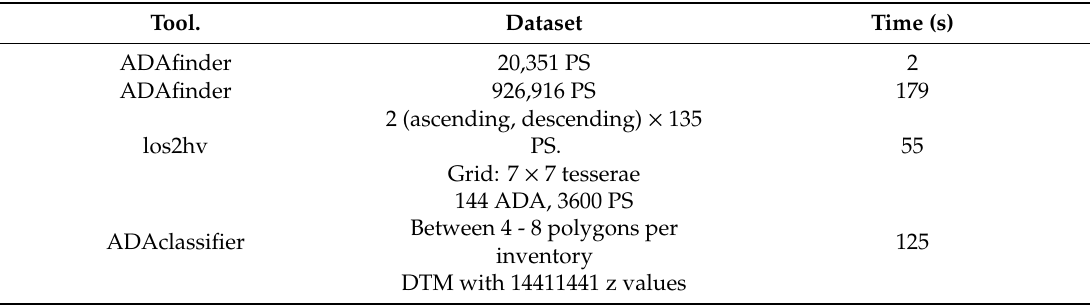
Table 1. Performance of the